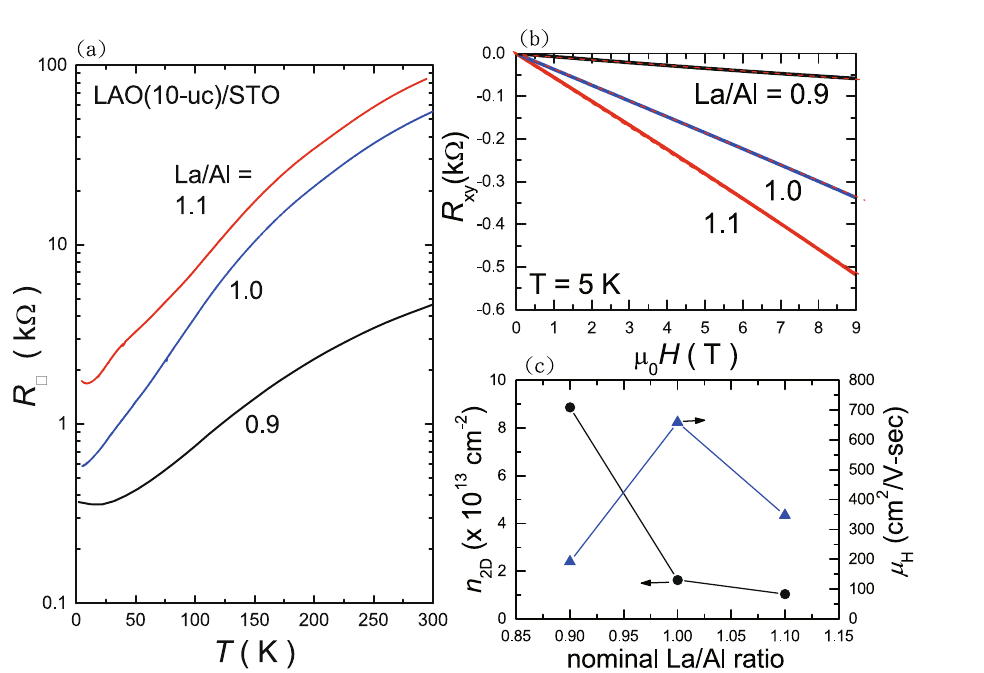
of the LAO film alone the STO[011] azimuth direction with LAO ‖ values for bulk STO and bulk LAO. ‖